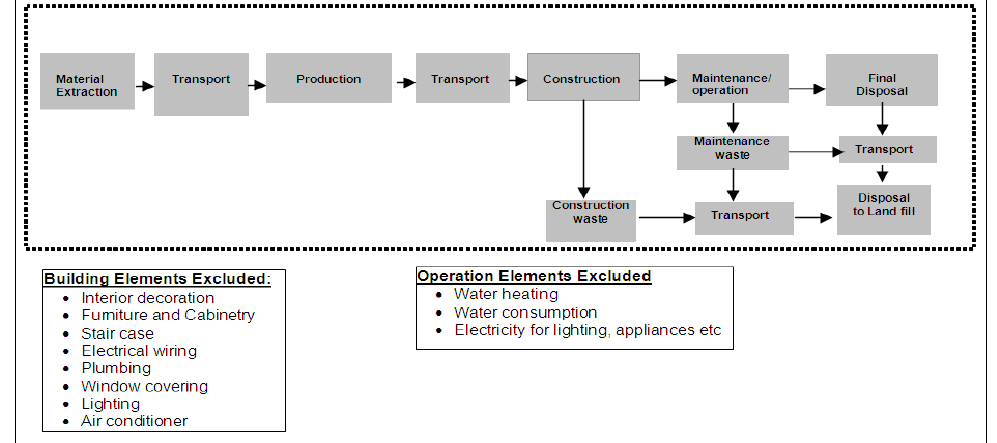
Figure 1. LCA system boundary.